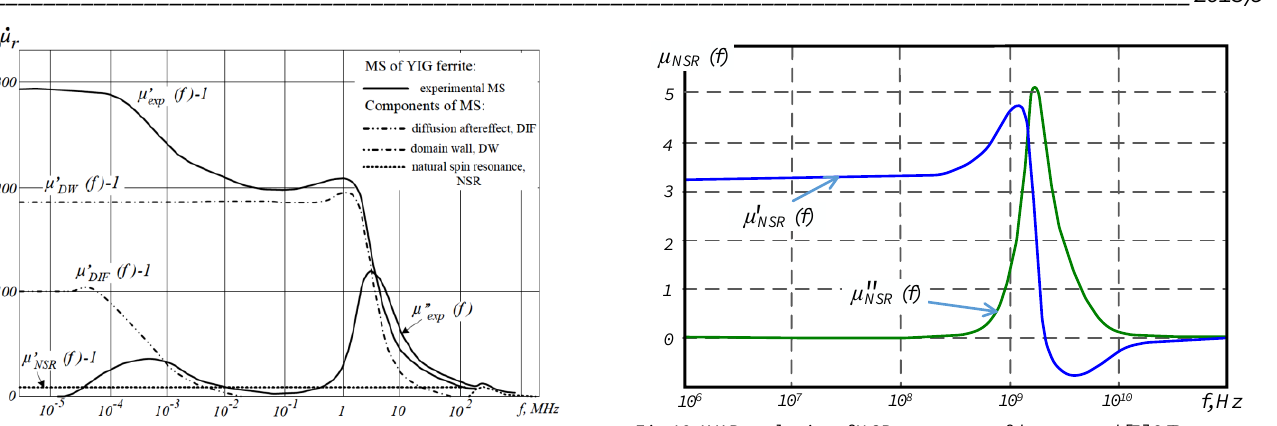
Fig. 10. Typical CIP dispersion regions [8] (calculated with KKR from 𝜇 ′′ (𝑓) ): 𝜇 𝐷𝑊 ′ (𝑓) – domain wall component, 𝜇 𝐷𝐼𝐹 ′ (𝑓) – diffusion aftereffect component, 𝜇 𝑁𝑆𝑅 ′ (𝑓) – natural spin resonance component.